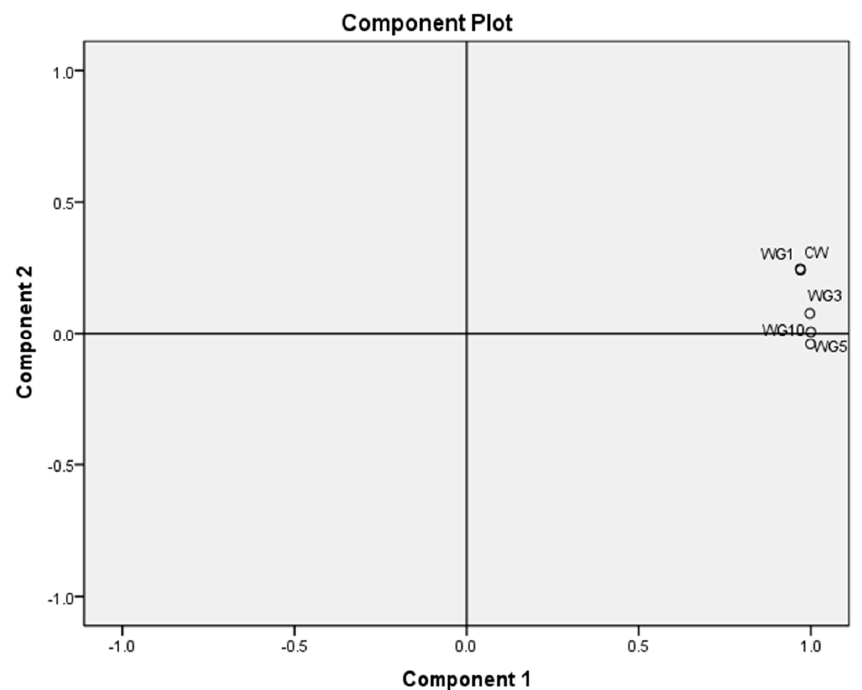
Processes 2021 , 9 , x FOR PEER REVIEW Figure 1. Principal component analysis (PCA) of chemical parameters (TPC, FRAP and DPPH) in